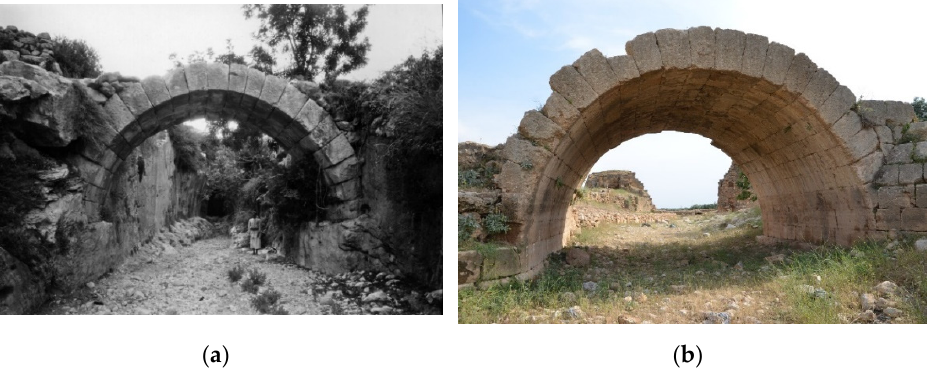
Figure 1. Dry-joint masonry arch bridges in Turkey: ( a ) Titus tunnel bridge, Hatay (Princeton Antioch expedition archives); ( b ) Dara stone bridge, Mardin (turkisharchaeonews.net).